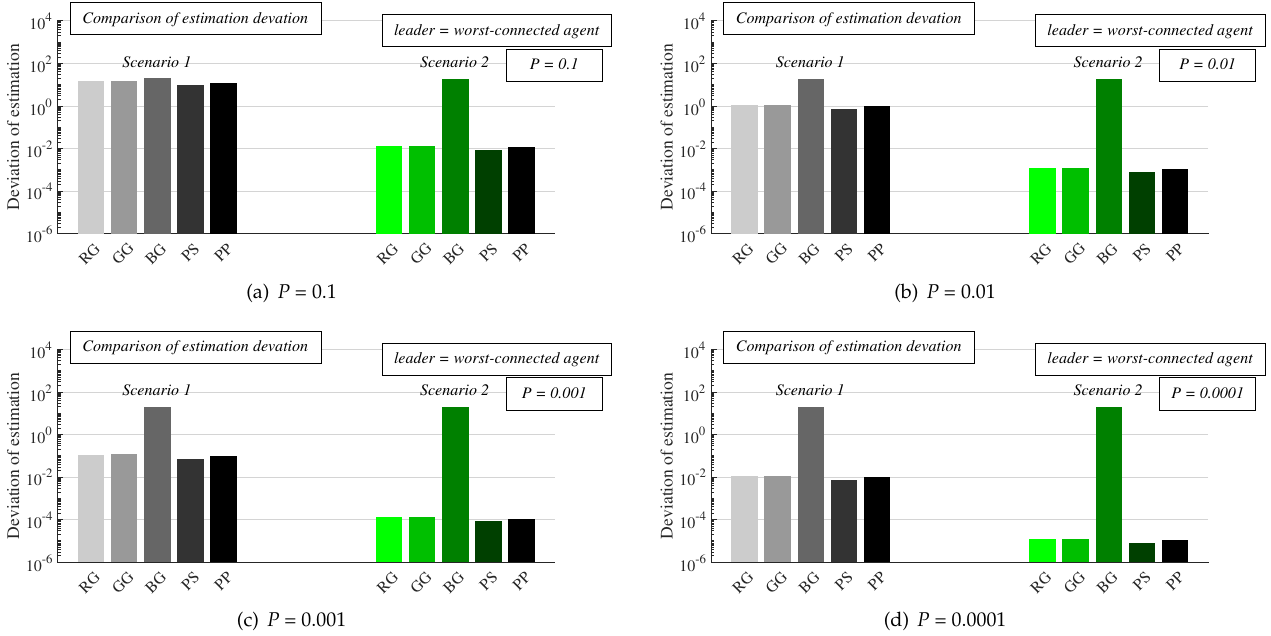
Figure 12. Comparison of the number of sent messages required for consensus achievement of all algorithms in both scenarios for various configurations of implemented stopping criterion—worst-connected agent is leader.